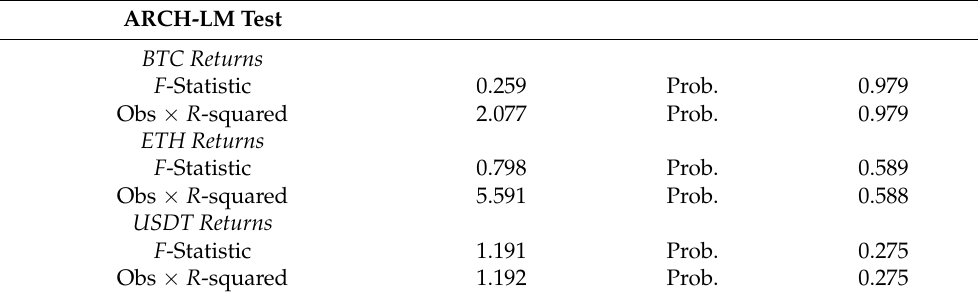
Table 3. ARCH-LM